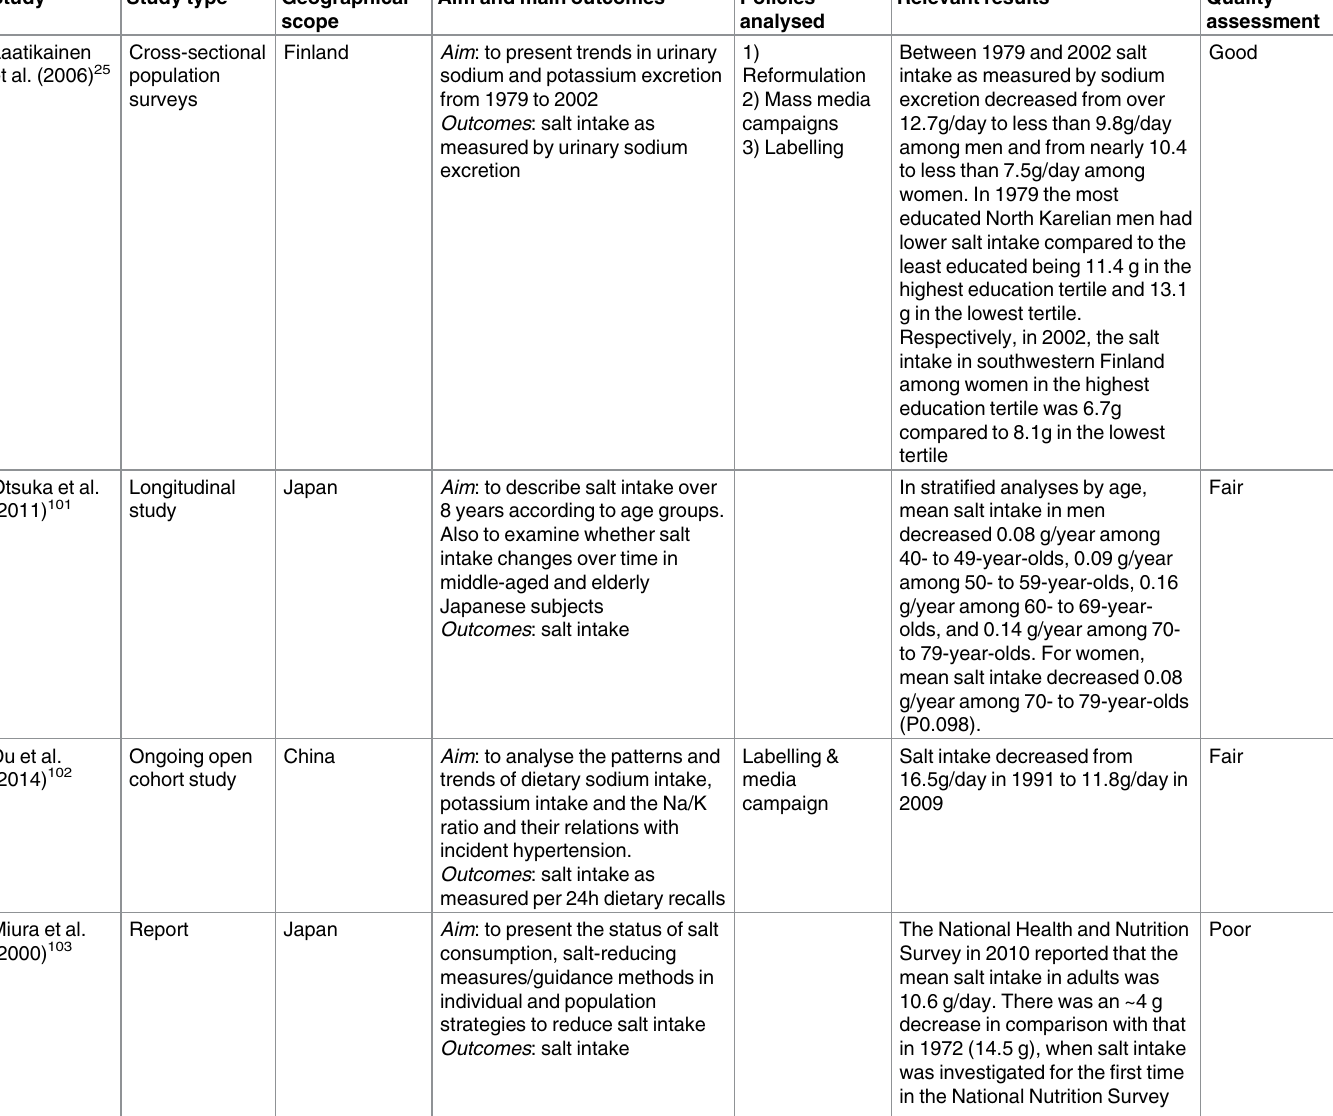
Table 10. Salt intake outcomes with interventions detailed in other